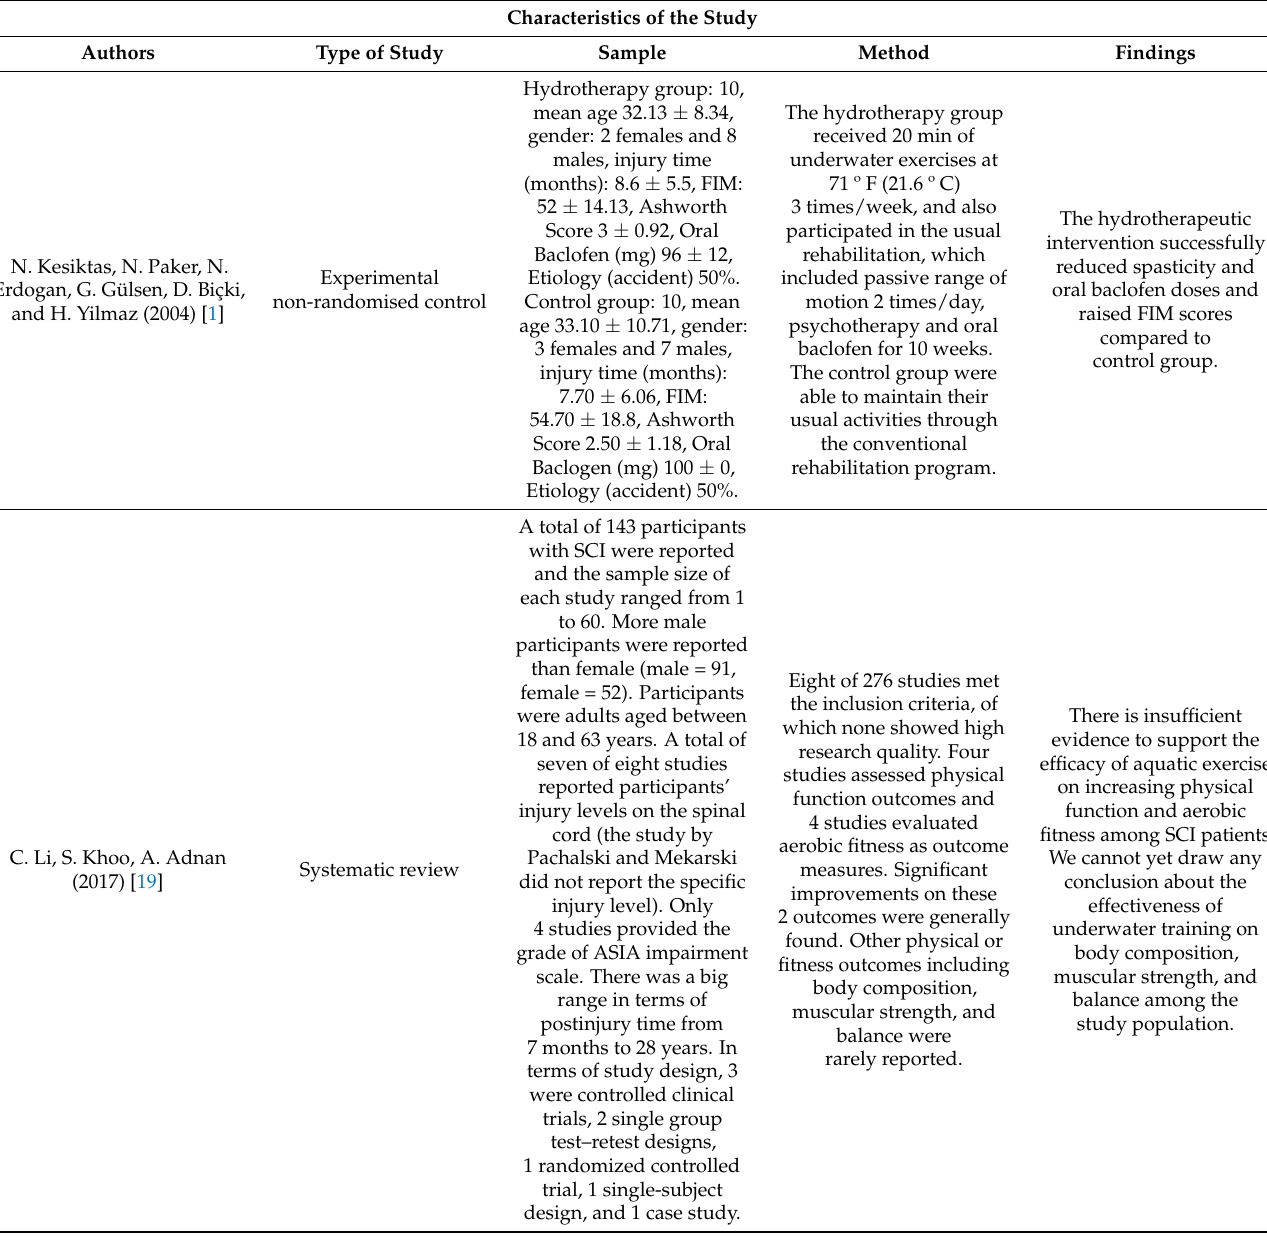
Table 2. Chronological overview of the characteristics and findings of the records ( n =